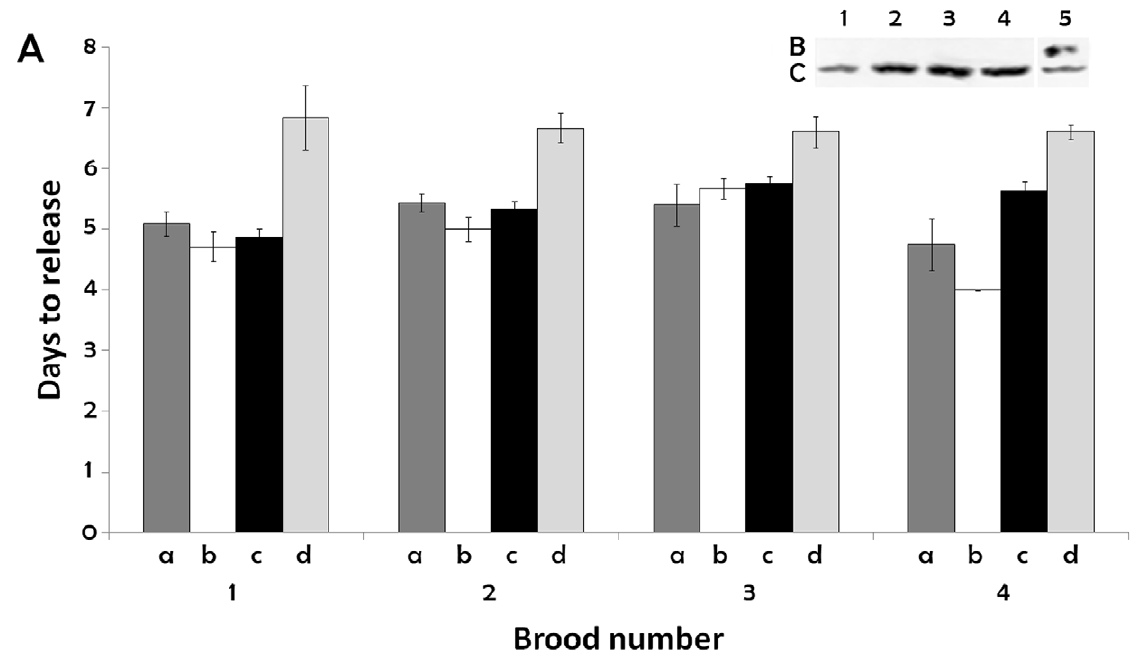
Figure 4. p26 knock down slows the development of diapause-destined Artemia embryos. A. The time to release in days for cysts and nauplii from females injected with control solution (a, c) and p26 dsRNA (b, d) for broods 1–4. a, nauplii; b, nauplii; c, cysts; d, cysts. n is 3 to 12 with lower values in higher brood numbers due to death of females with increased culture time. The bars indicate standard error for each measurement. Inset B. Protein extracts from cysts in broods 1–4 were resolved by SDS polyacrylamide gel electrophoresis, blotted to nitrocellulose and probed with antibody to p26 followed by HRP conjugated goat anti-rabbit IgG. Inset C. After stripping the blot was probed with antibody to ArHsp21. Lane 1, brood 1; 2, brood 2; 3, brood 3; 4, brood 4; 5, protein extract from commercially obtained cysts containing p26 and ArHsp21. Proteins reacting with antibodies were visualized by chemiluminescence.